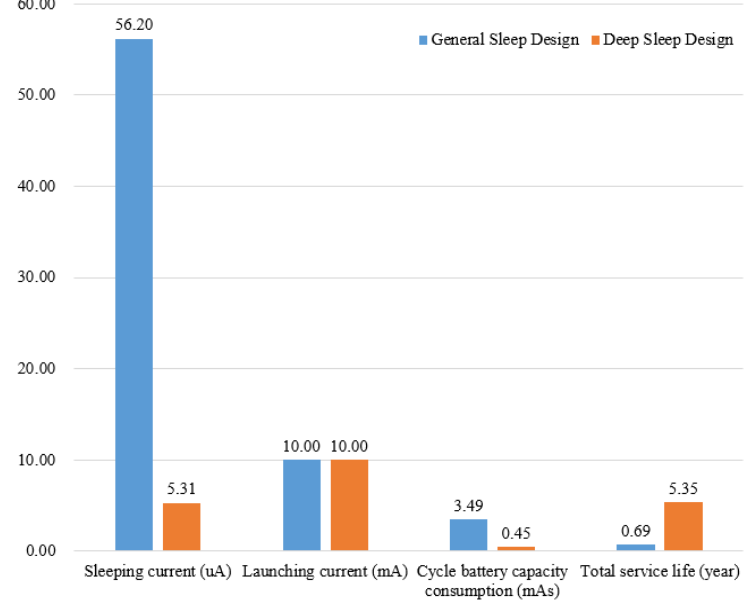
Figure 21. Performance comparison between the general sleep design and the proposed power-saving deep sleep design.